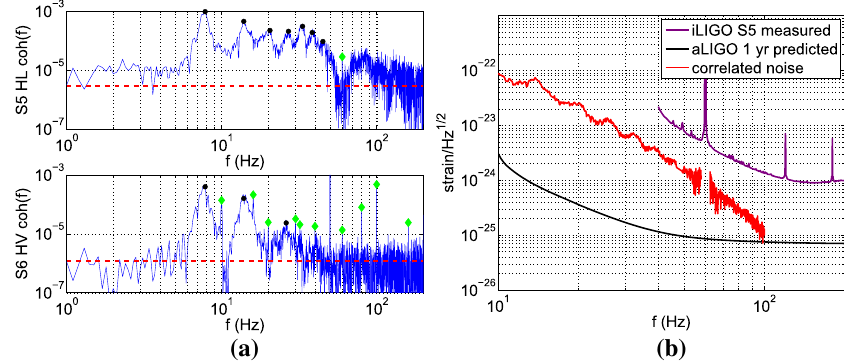
Fig. 77 Panel a shows the cross-correlation of magnetometer readings between the LIGO-Hanford and LIGO-Livingston sites (HL), and also the LIGO-Hanford and Virgo sites (HV). The peaks indicated by black dots are due to Schumann resonances. The green dots mark peaks that are due to correlations caused bytheelectronics.Panel b showstheamplitudespectraoftheinitialandadvancedLIGOdetectorscompared to the estimated level of the correlated noise due to Schumann resonances. The correlated noise level in advanced LIGO should be lower due to differences in the design (notably the lack of magnets attached to the mirrors). Images reproduced with permission from Thrane et al. (2013), copyright by